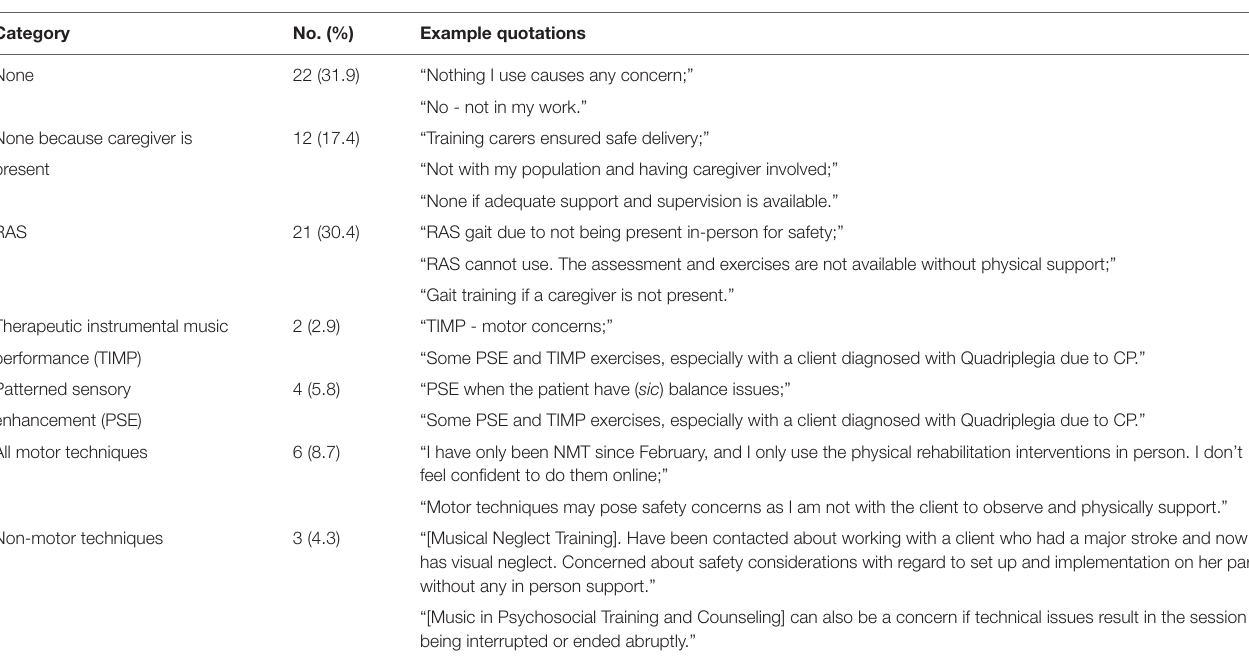
TABLE 5 | NMT techniques posing safety